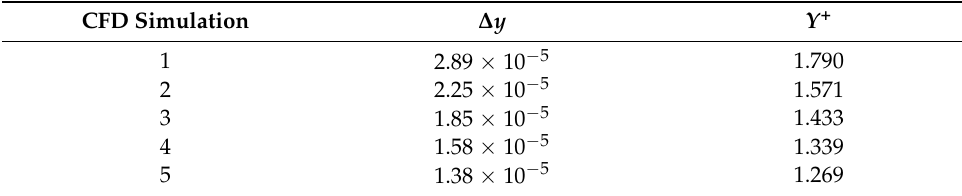
Table 1. Grid optimization with improving Y + .